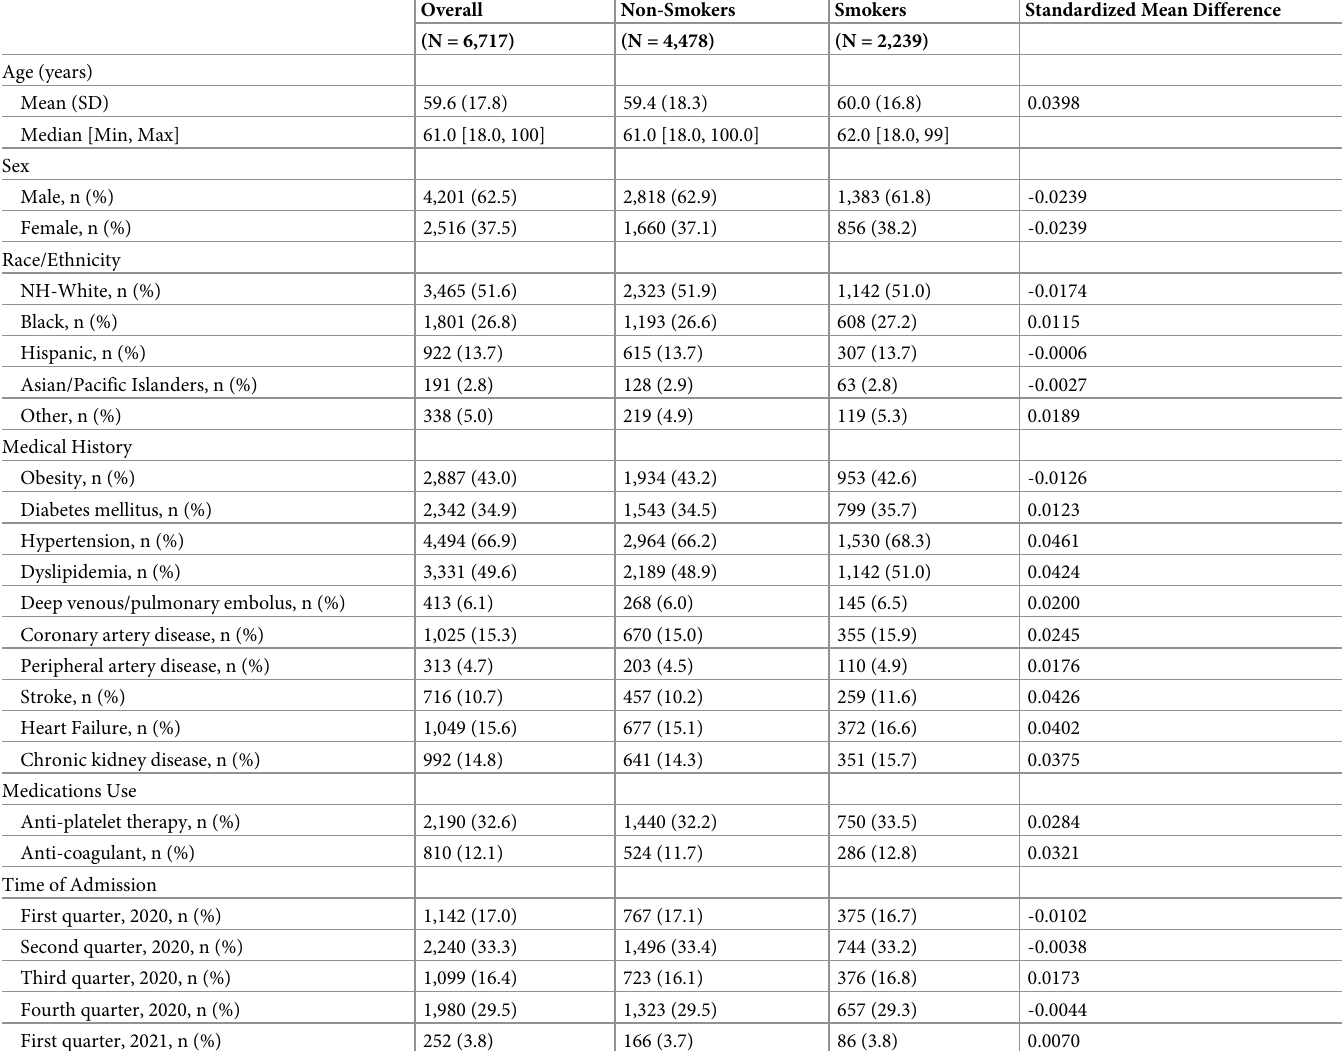
Table 1. Univariate analysis of the propensity-matched study population in the AHA COVID-19 CVD Registry from December 2020 to March 2021 stratified by smoking